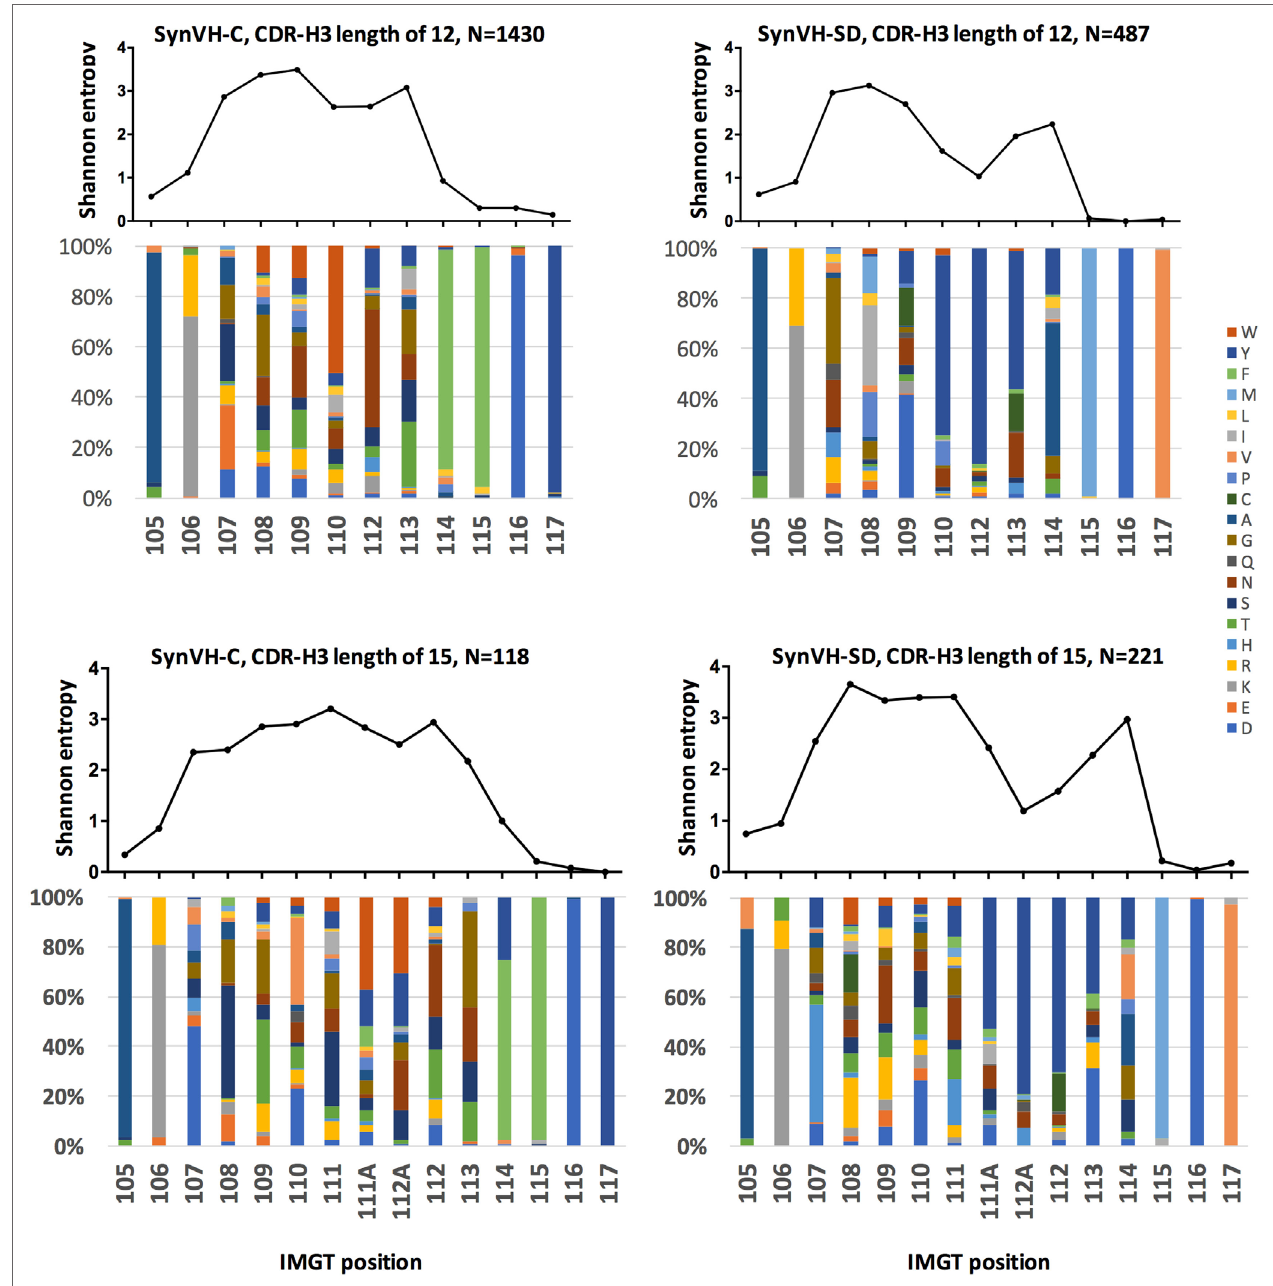
FigUre 5 | Sequence diversity in CDR-H3 is similar in SynVH-C and SynVH-SD. Shannon entropy and amino acid distribution for each position of CDR-H3 IMGT positions 105–117 are shown for the specific lengths of 12 residues (top two panels) and 15 residues (bottom two panels) for SynVH-C and SynVH-SD. The sequences were drawn from the top 1,000 sequences from each bird; SynVH-C, six birds, SynVH-SD, three